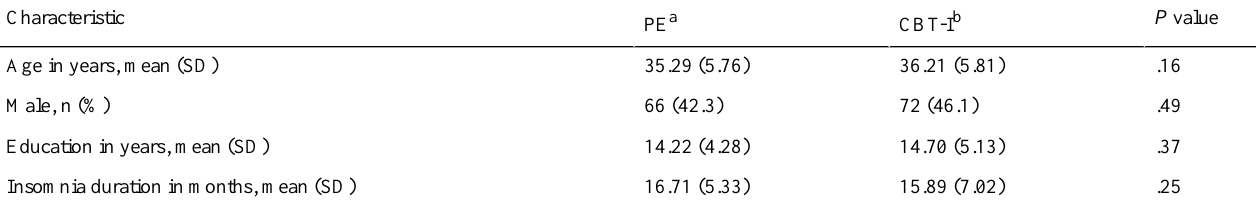
Table 2. Demographic characteristics by condition